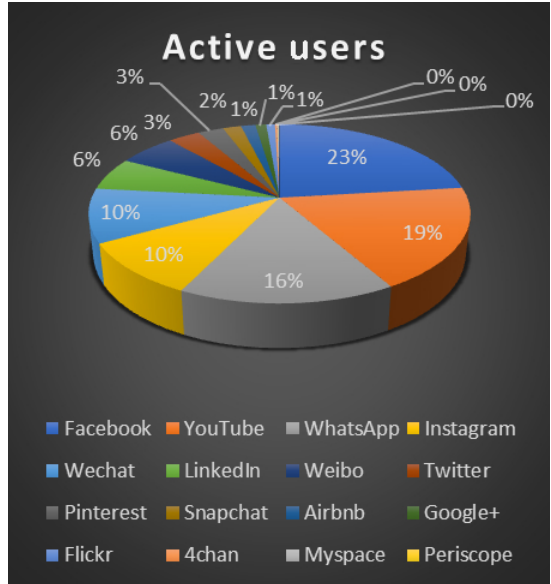
Fig. 3 Active users in social media in